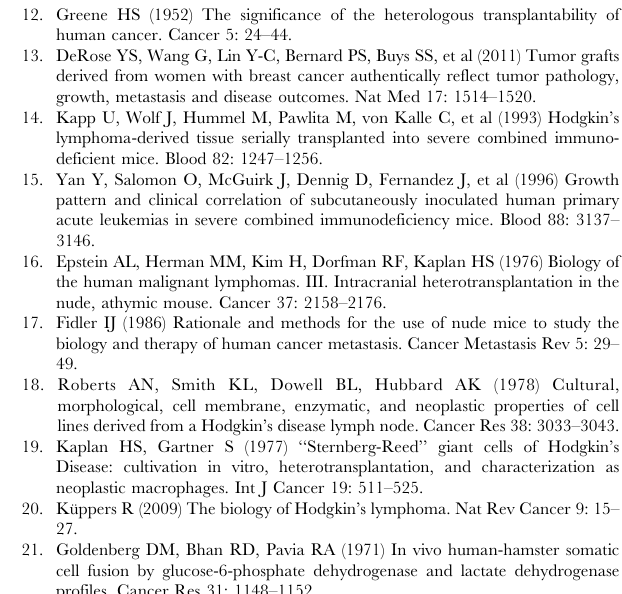
Table S1 Primer sequences employed for PCR detec- tion of human genes. Table S2 Human proteins tested on the GW-532 and GW-584 lymphomas by immunohistochemistry of pri- mary and/or xenograft